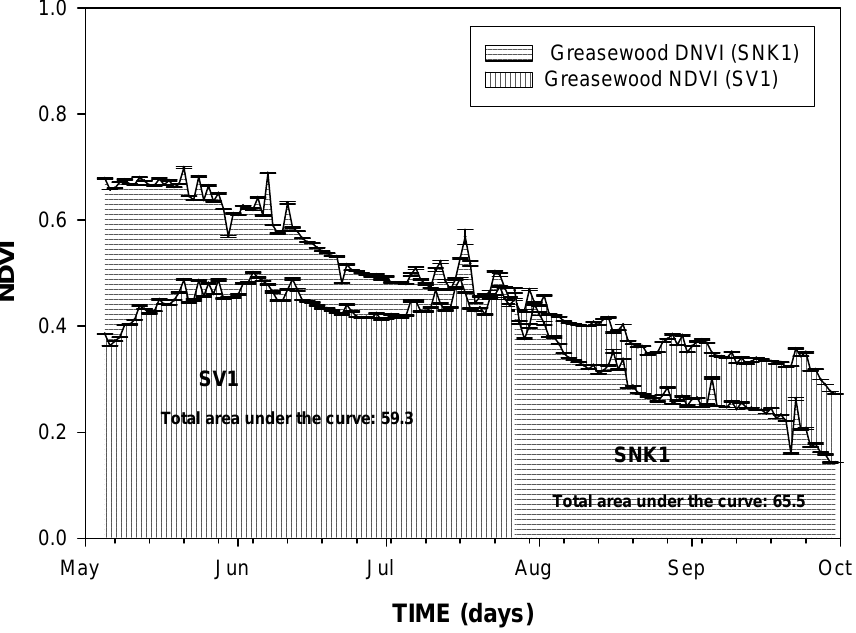
Figure 3. Time series of average midday (11:30–13:30h) NDVI values of a single greasewood plant at Spring Valley 1 site and at Snake Valley 1 site. Data were acquired during the experimental period from May 5 to September 30, 2007. The area under the curve represents an integrated greasewood growth total of 59.31 for the Spring Valley 1 site and 65.47 for the Snake Valley 1